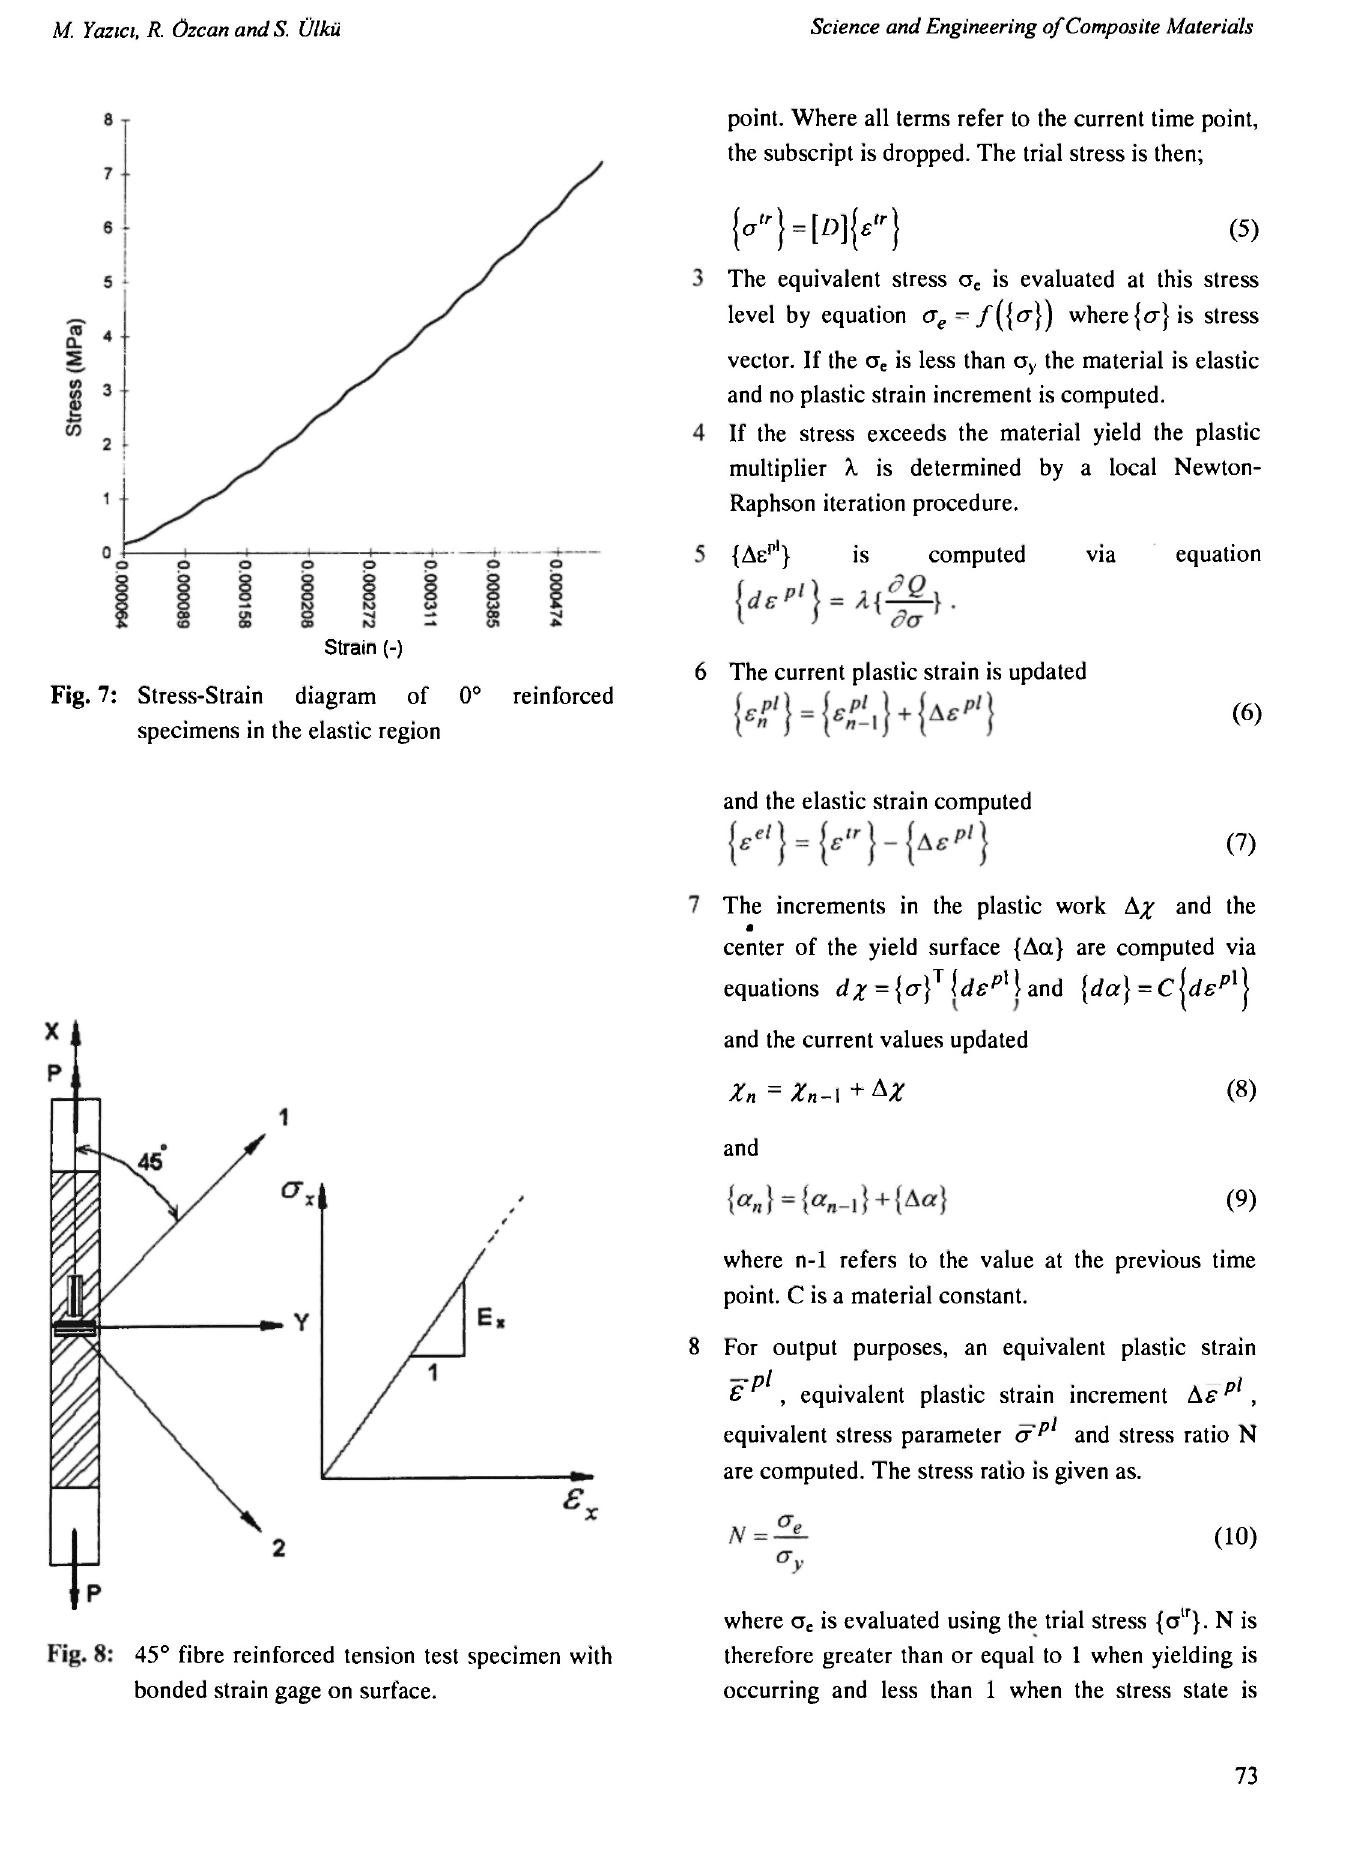
Strain (-) Fig. 7: Stress-Strain diagram of 0° reinforced specimens in the elastic region